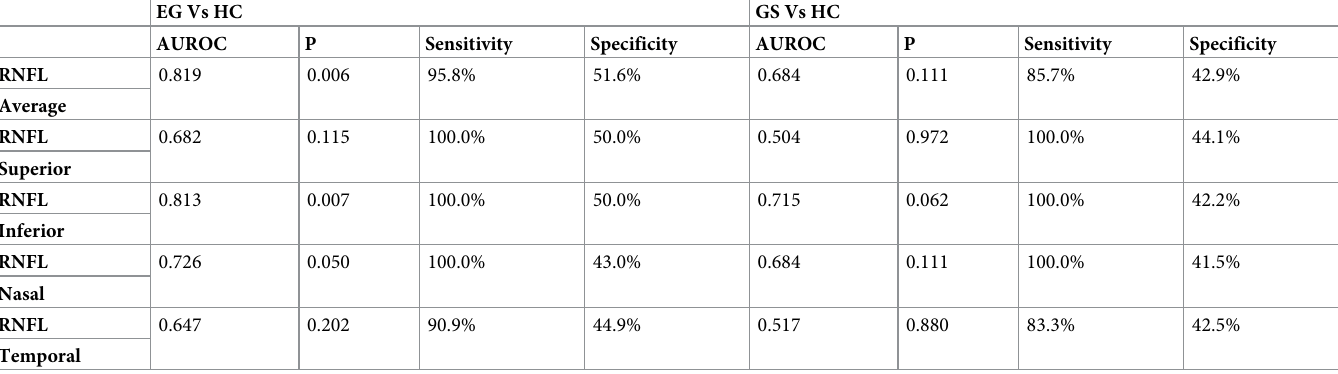
Table 5. Area under receiver operating curve (AUROC), sensitivity and specificity of the RNFL parameters in diagnosis of early glaucoma (EG) and glaucoma sus- pect (GS). EG Vs